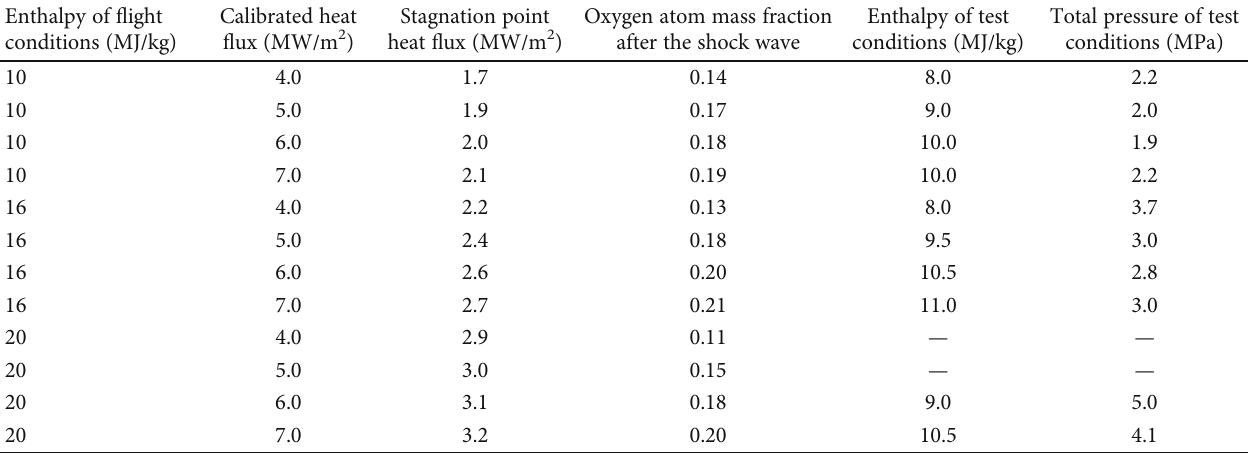
Table 4: The conditions under similar stagnation point heat fl ux and oxygen atom mass fraction after the shock wave. Enthalpy of fl